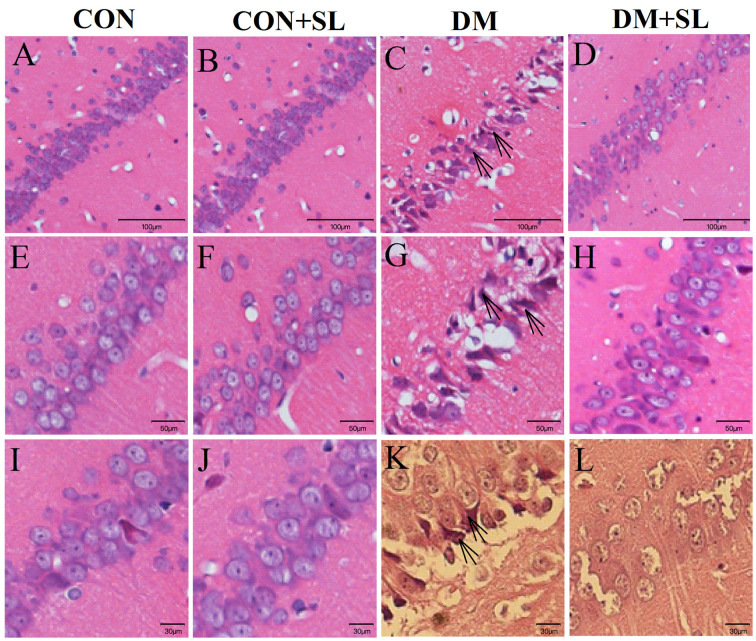
Morphological changes in the neurons in the CA1 hippocampal region of diabetic rats were observed under an optical microscope. Representative images of HE staining in brain slices of the hippocampus. (A–D) Magnification 4×, (E–H) Magnification 10×, (I–L) Magnification 40×. The arrow points to a positive sign (disorder arrangement, dilated intercellular spaces and karyopyknosis) n = 5.